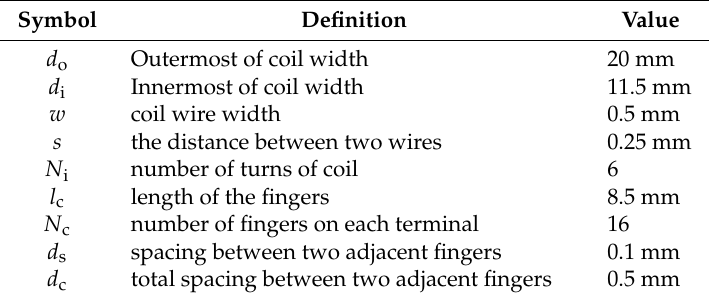
Figure 1. Schematic diagram of the inductive-capacitive (LC) proximity sensor based on low temperature co-fired ceramic (LTCC). Table 1. Parameters of the designed LC proximity sensor.